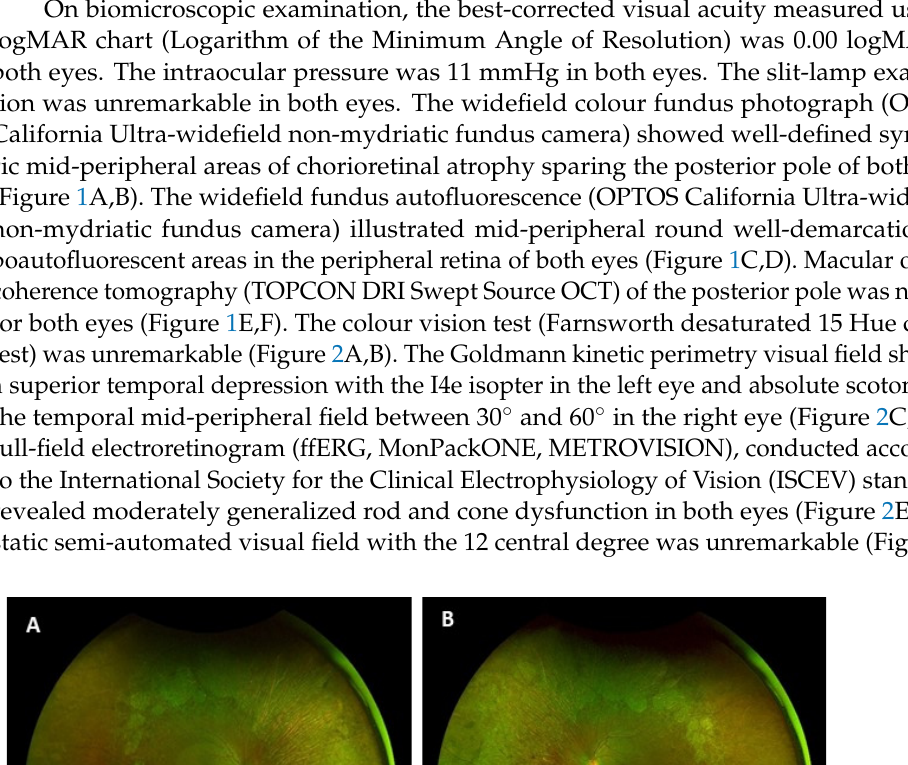
Figure 1. Ultra-widefield fundus photographs of the right ( A ) and left ( B ) eye performed using the optos camera showed well-delineated concentrical mid peripheral patches of chorioretinal atrophy sparing the macula in both eyes. Ultra-widefield short-wavelength fundus autofluorescence illustrated mid-peripheral round well-demarcated patchy loss of autofluorescence in both eyes ( C , D ). Macular Optical coherence tomography (OCT) photos showed no macular abnormality in either eye ( E , F ).